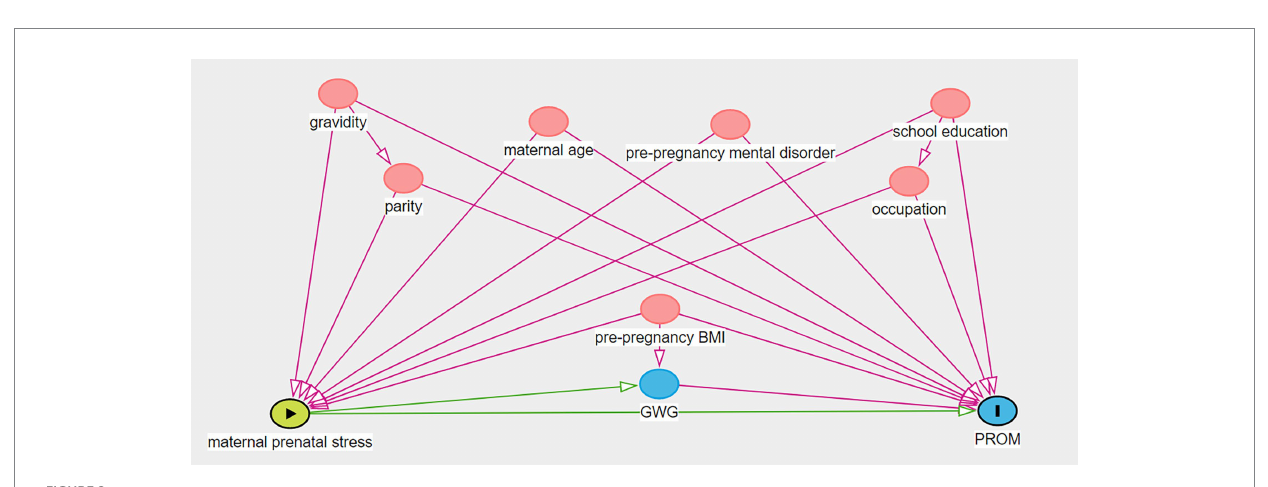
FIGURE 1 Analytic sample flow chart.